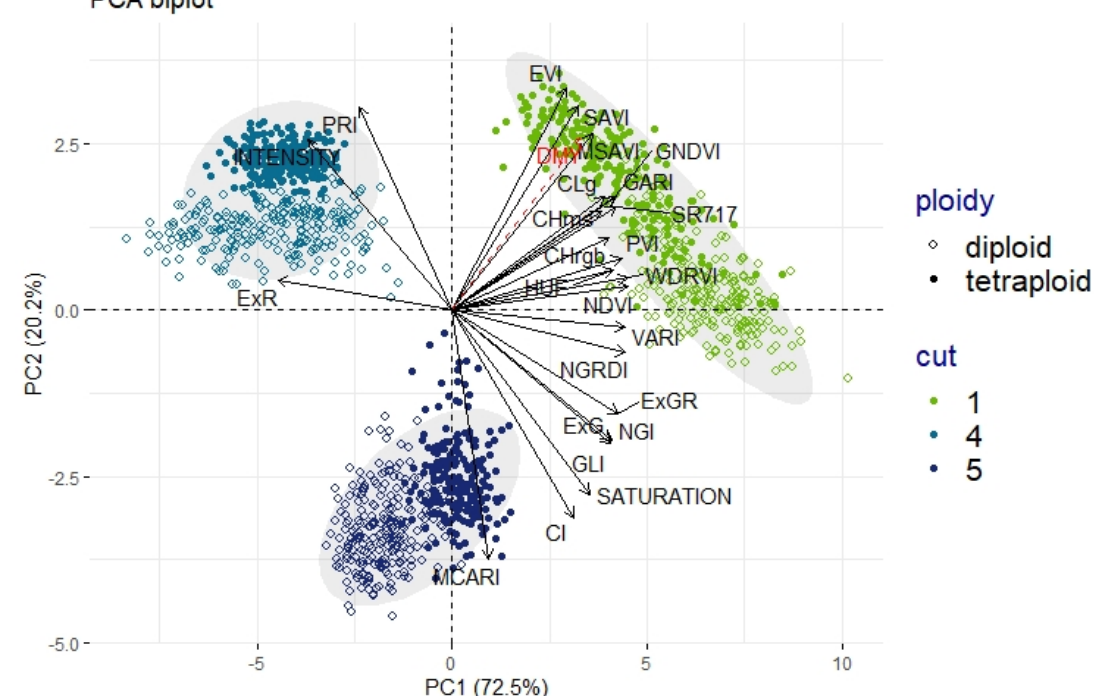
Figure 5. A biplot of the first two dimensions (PC1 and PC2) of a principal component analysis carried out on the plot scores for the CH and VIs values based on RGB and MS imagery. Dots indicate median values per plot and are labelled according to cut and ploidy level. Vectors are loadings that project the variable information over the first two PCs. The dry matter yield (DMY, indicated as a red dashed line) data are presented as a quantitative supplementary variable, but was not included in the